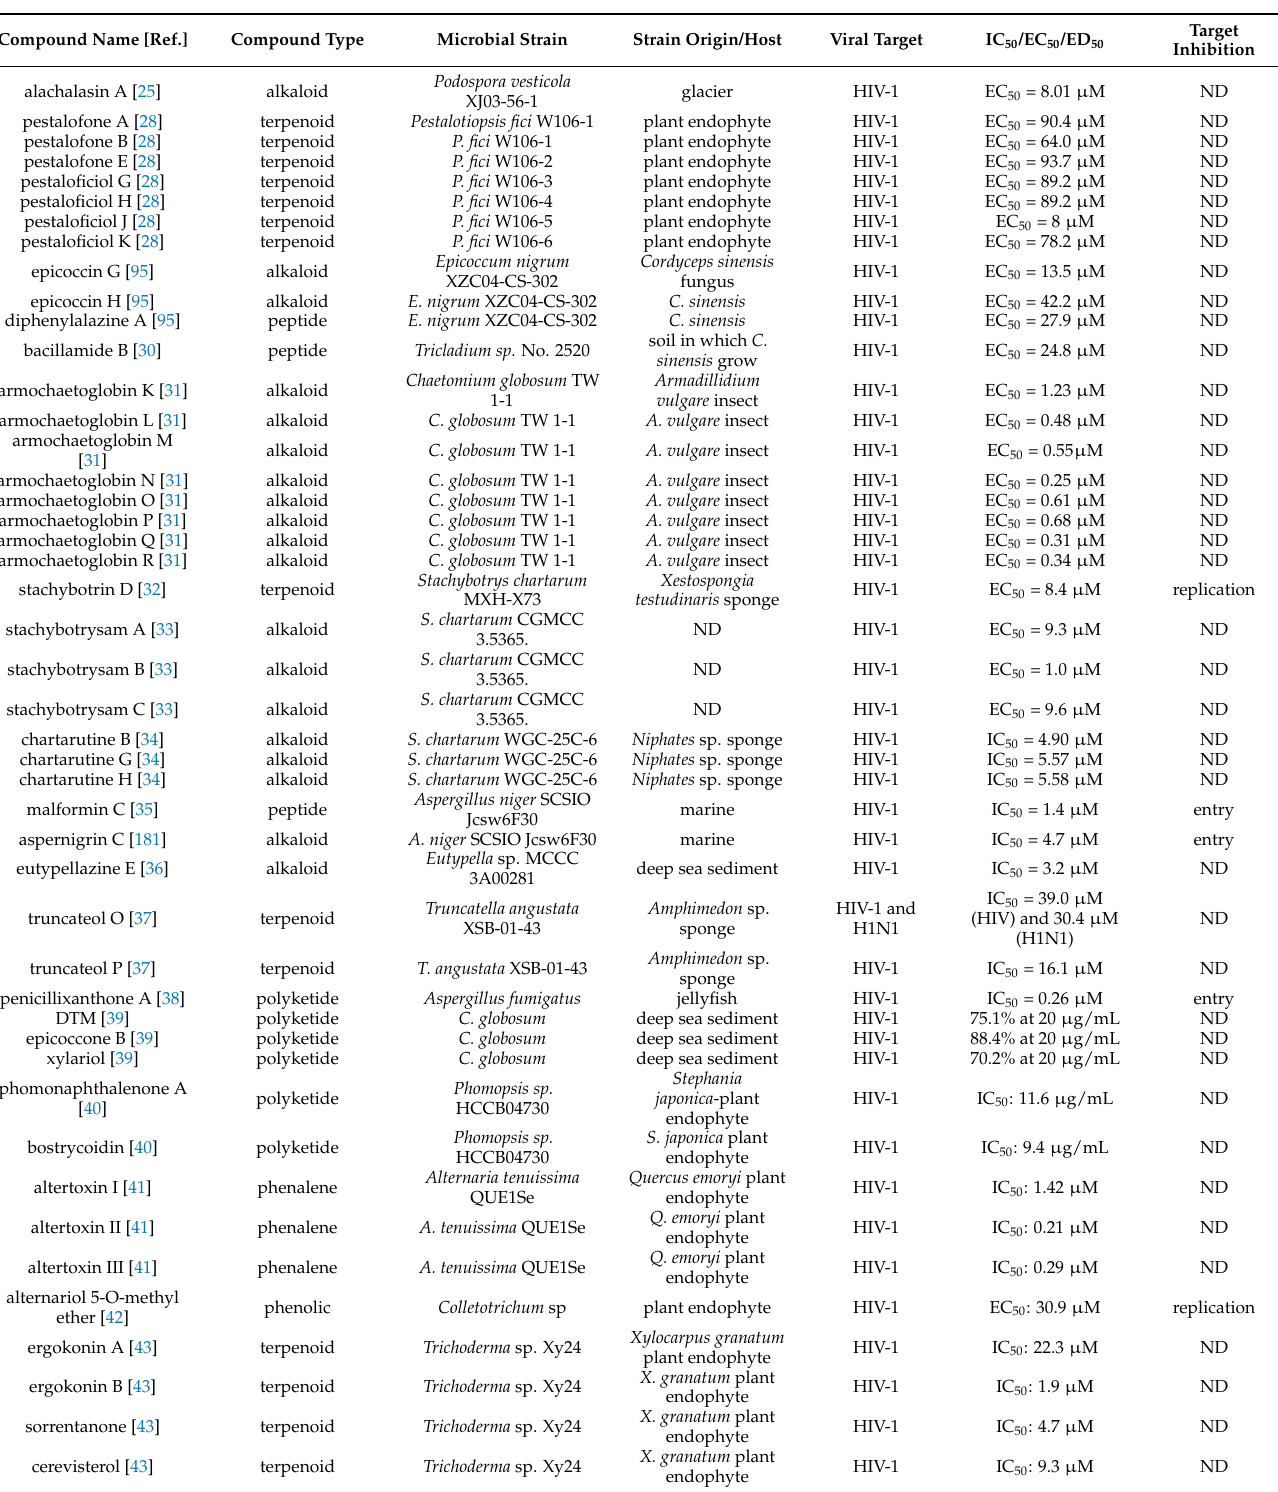
Table 2. Natural product produce by microbes and its